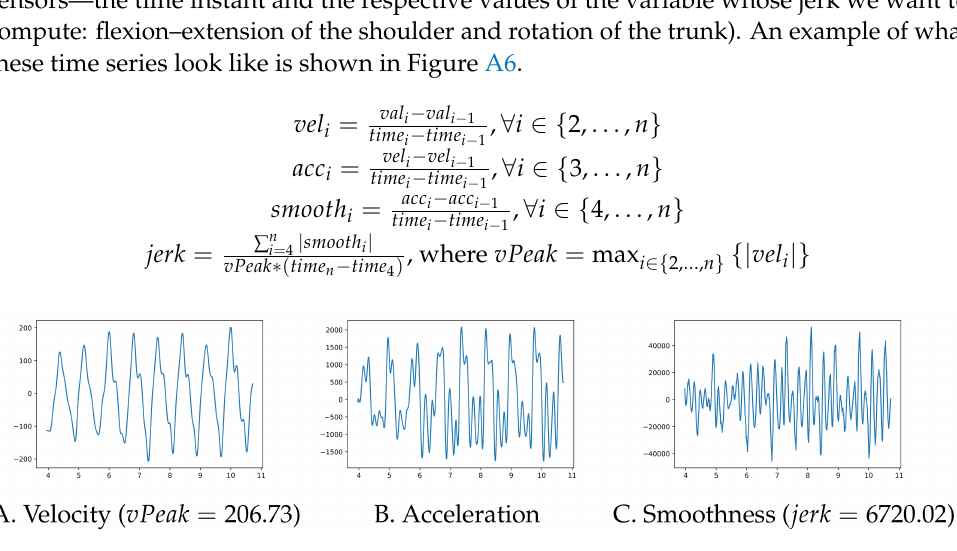
Figure A6. Velocity, acceleration and smoothness in the same HC